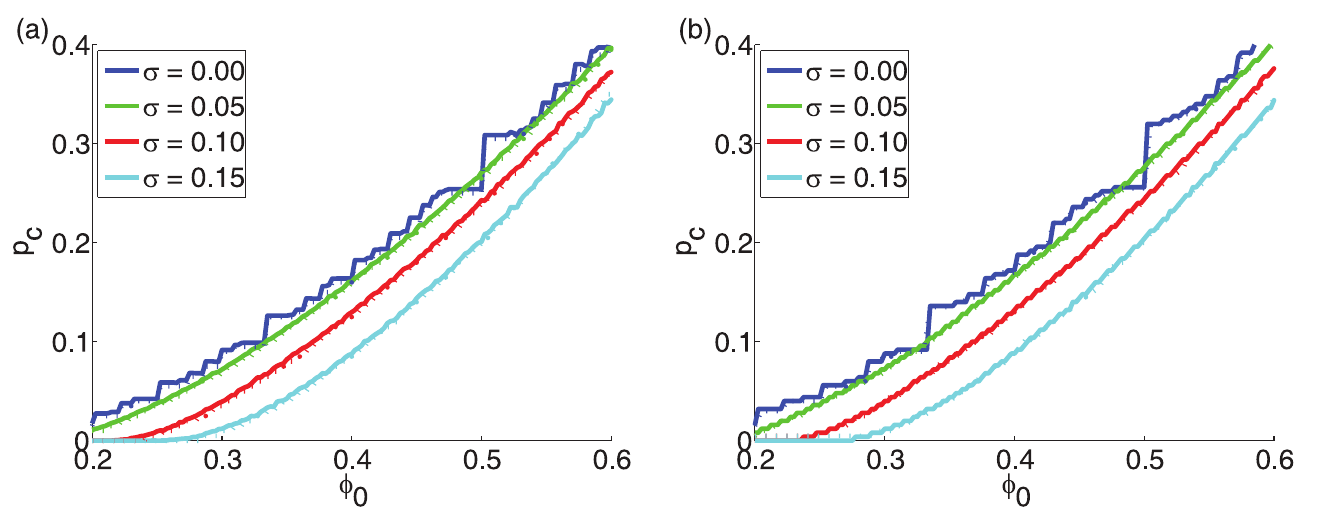
Fig 6. Critical initiator fraction p c vs. mean threshold ϕ 0 . (a) ER graphs and (b) SF networks with γ = 3 with average degree z = 10 and system size N = 10 4 . An initiator size above the p c line leads to global cascades. The analytic estimates (dotted lines) are based on the tree-like approximation [14] (see Materials and Methods).